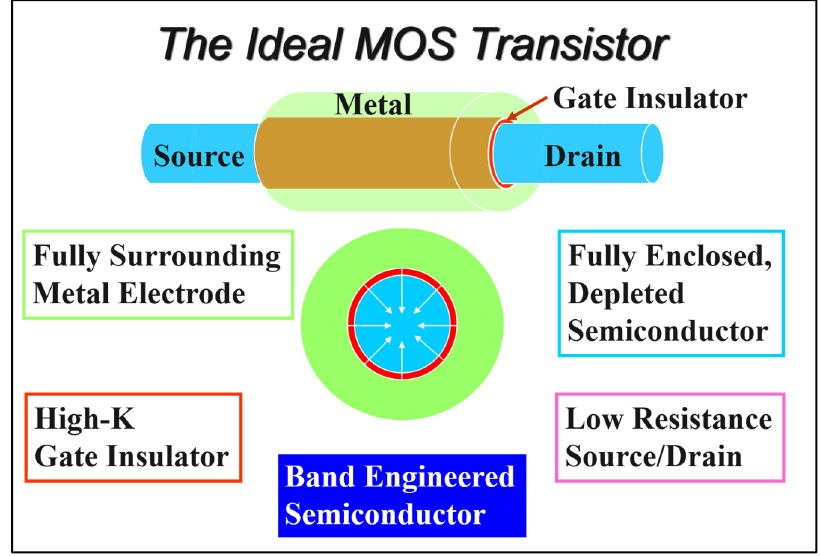
Figure 2. The vision of innovative MOS transistor.